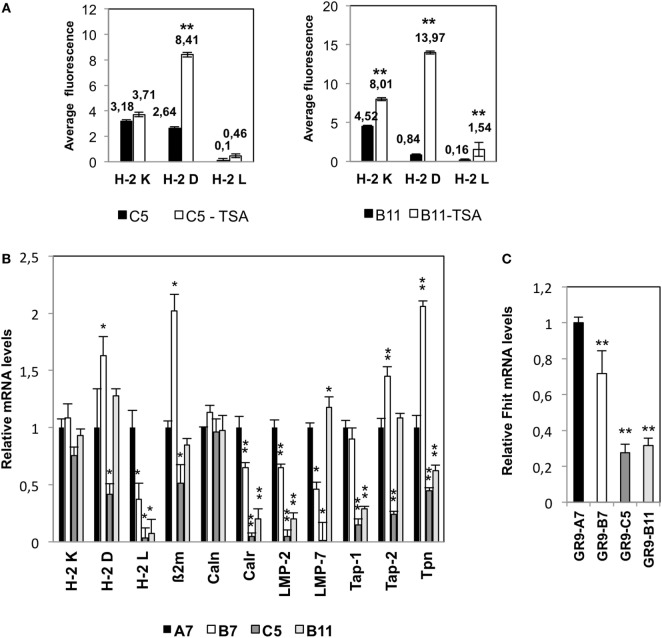
(A) Mean fluorescence values for H-2 class I expression under baseline conditions and after treatment with trichostatin A (TSA, 500 nM for 48 h). A representative example of three independent experiments is depicted. **p < 0.01. A two-tailed Student t-test was used for statistical analysis. (B) Transcription levels of H-2 class I heavy chain, β2-microglobulin, and several APM components detected by real-time RT-PCR. (C) Expression of Fhit in fibrosarcoma cell lines. Expression levels of the genes of interest were determined relative to levels of β-actin and GADPH housekeeping genes. Data for GR9-A7 are set at 1. Values are depicted as means ± SD of three independent experiments performed in quadruplicate. *p < 0.05; **p < 0.01 vs. the A7 values. ANOVA test, followed by Tukey post hoc test was used for statistical analysis.